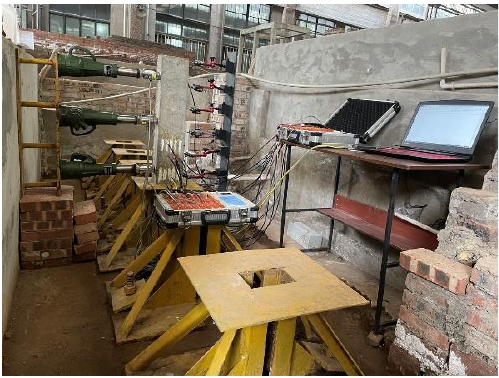
Figure 5. Load test on the test pile.